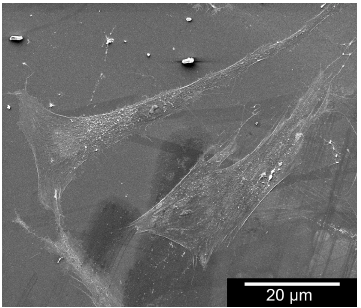
Figure 11. ESEM image of OB after 48 h incubation on Thermanox-membranes.